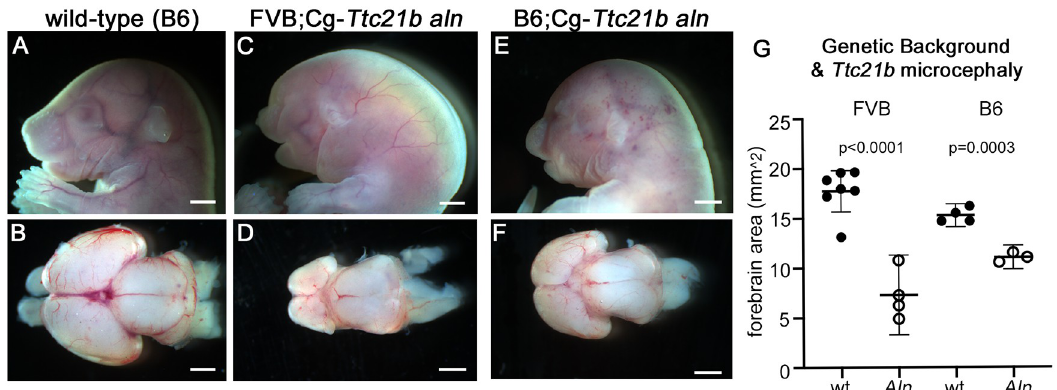
Fig 1. Genetic background affects the Ttc21b aln/aln microcephaly phenotype. (A-F) Embryos and whole mount brains viewed from the dorsal aspect from control (A,B, E17.5), FVB;Cg- Ttc21b aln/aln mutants (C,D, E18.5), and B6;Cg- Ttc21b aln/aln mutants (E,F, E17.5). (G) Relative forebrain dorsal surface areas between wild-type and Ttc21b aln/aln mutants from each genetic background. Data shown are mean ± 95% confidence interval. n = 7, 4, 4, 3 sample points. Scale bars in A-F indicate 1mm.